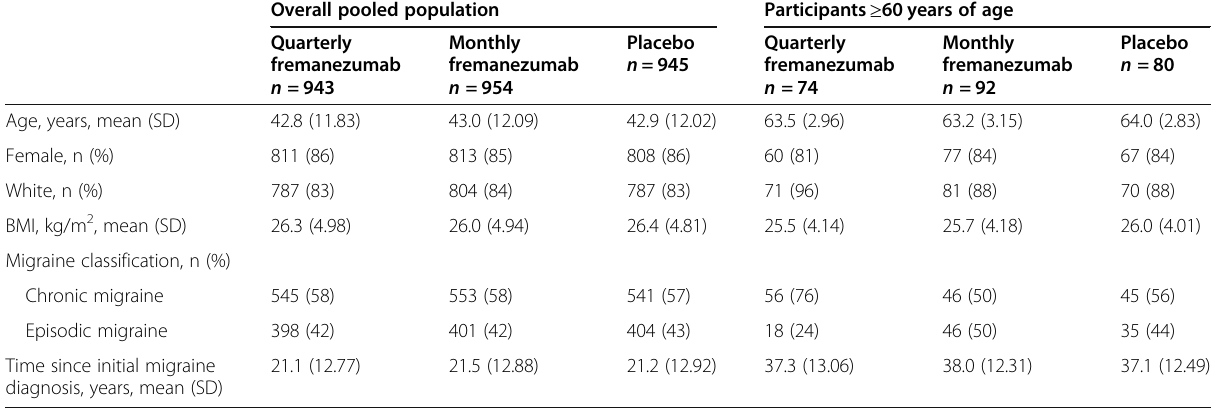
Table 1 Demographics and baseline characteristics of participants ≥ 60 years of age and overall